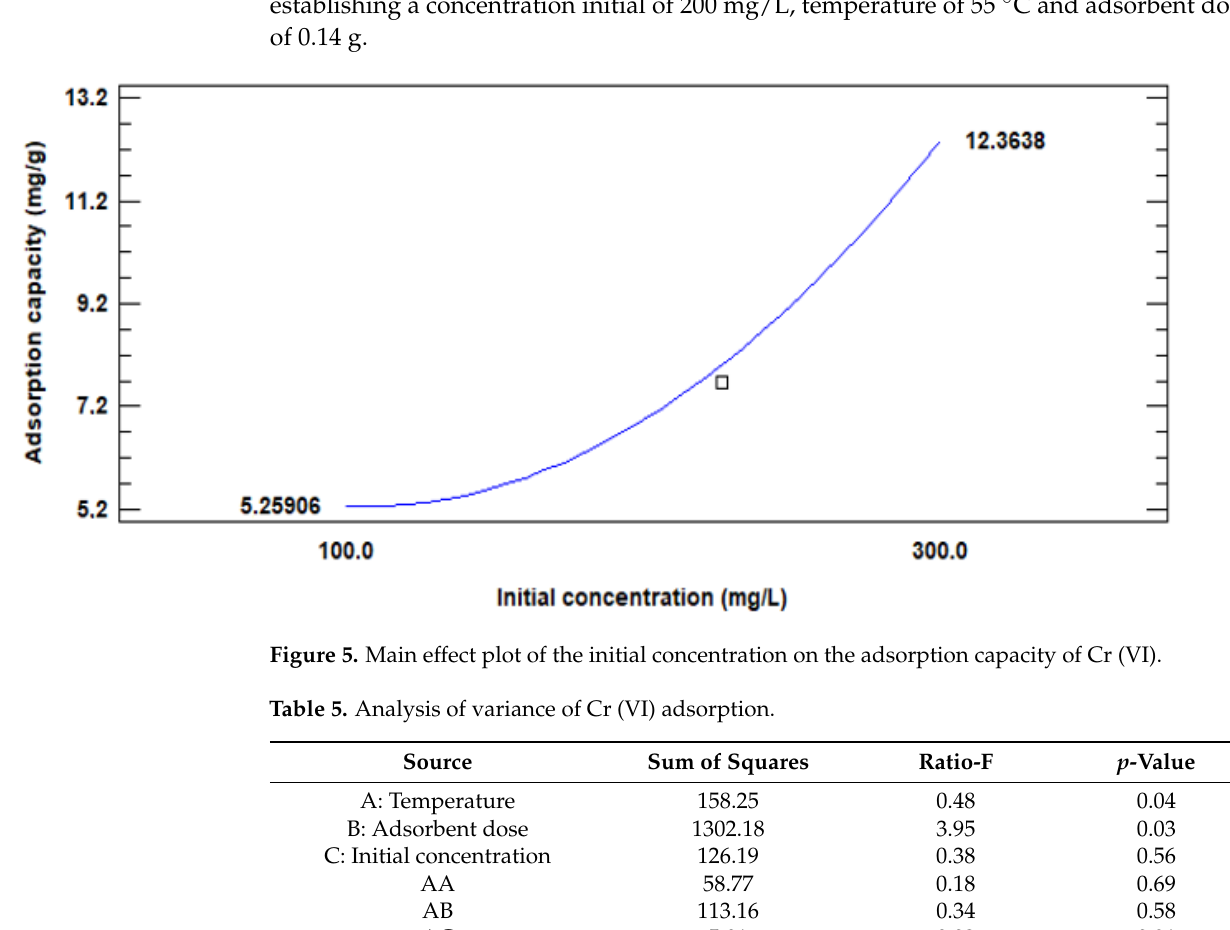
Table 5. Analysis of variance of Cr (VI) adsorption.